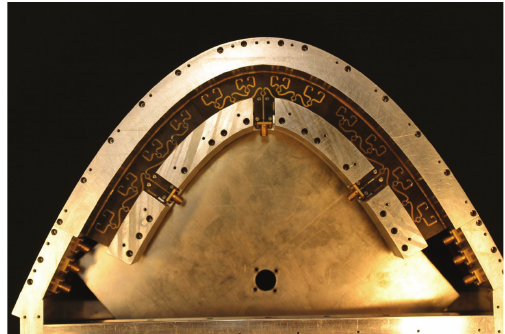
Figure 5: Feed and calibration network of the ERAKO antenna array seen from below.